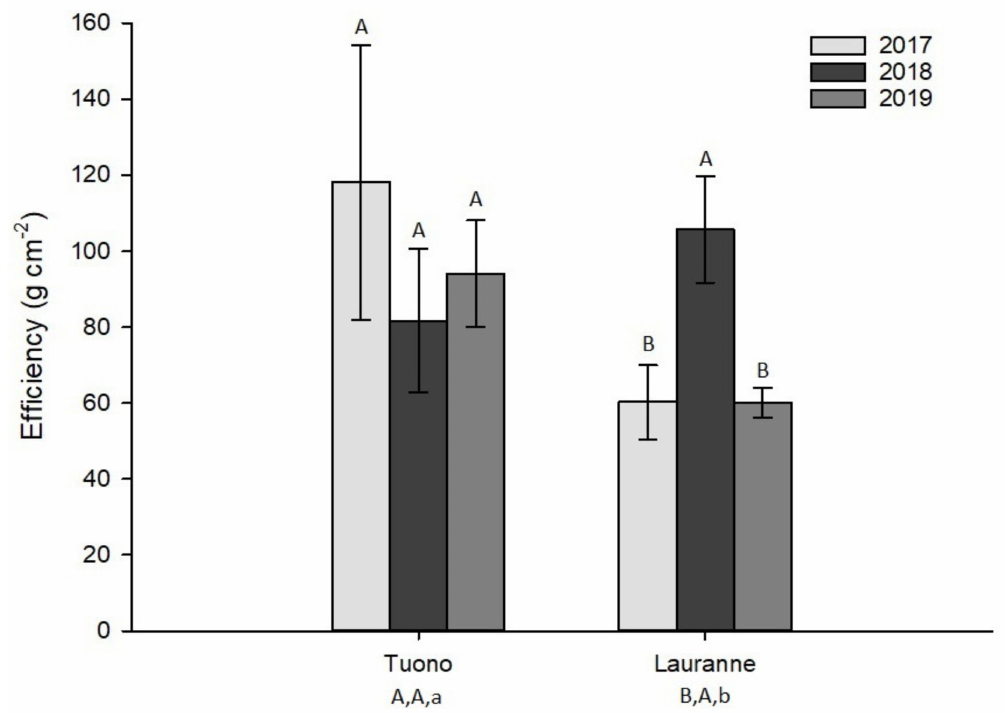
Figure 7. Efficiency on trunk section (g cm − 2 ) of cultivars Tuono and Lauranne in three subsequent years (2017–2019). The letters on the bars denote statistical differences among years for each cultivar; the letters on the x-axis denote statistical differences between cultivars for each year (SNK test). Lower case letters denote statistical differences at p = 0.05; capital letters denote statistical differences at p =